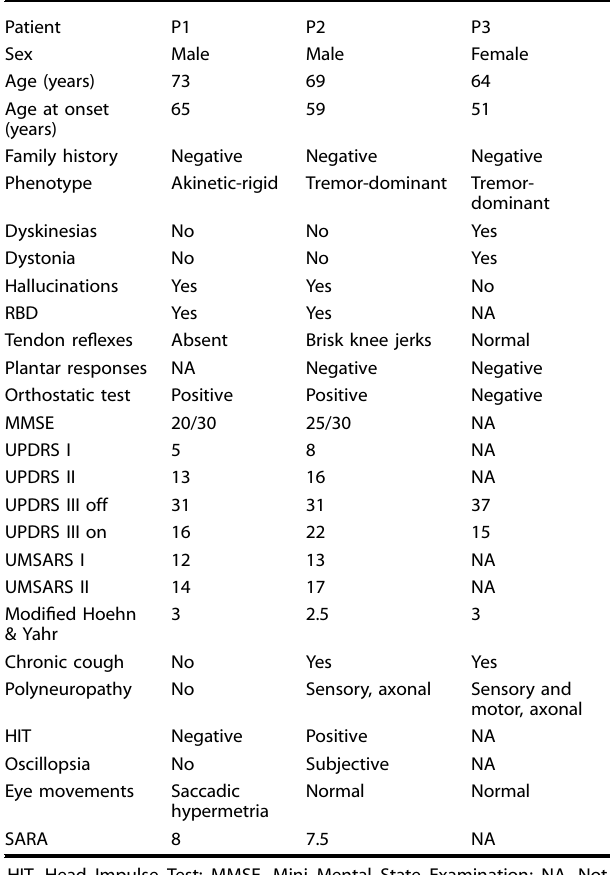
Table 1. Clinical characteristics of the three patients with Parkinson ’ s disease and with biallelic (AAGGG) exp in RFC1